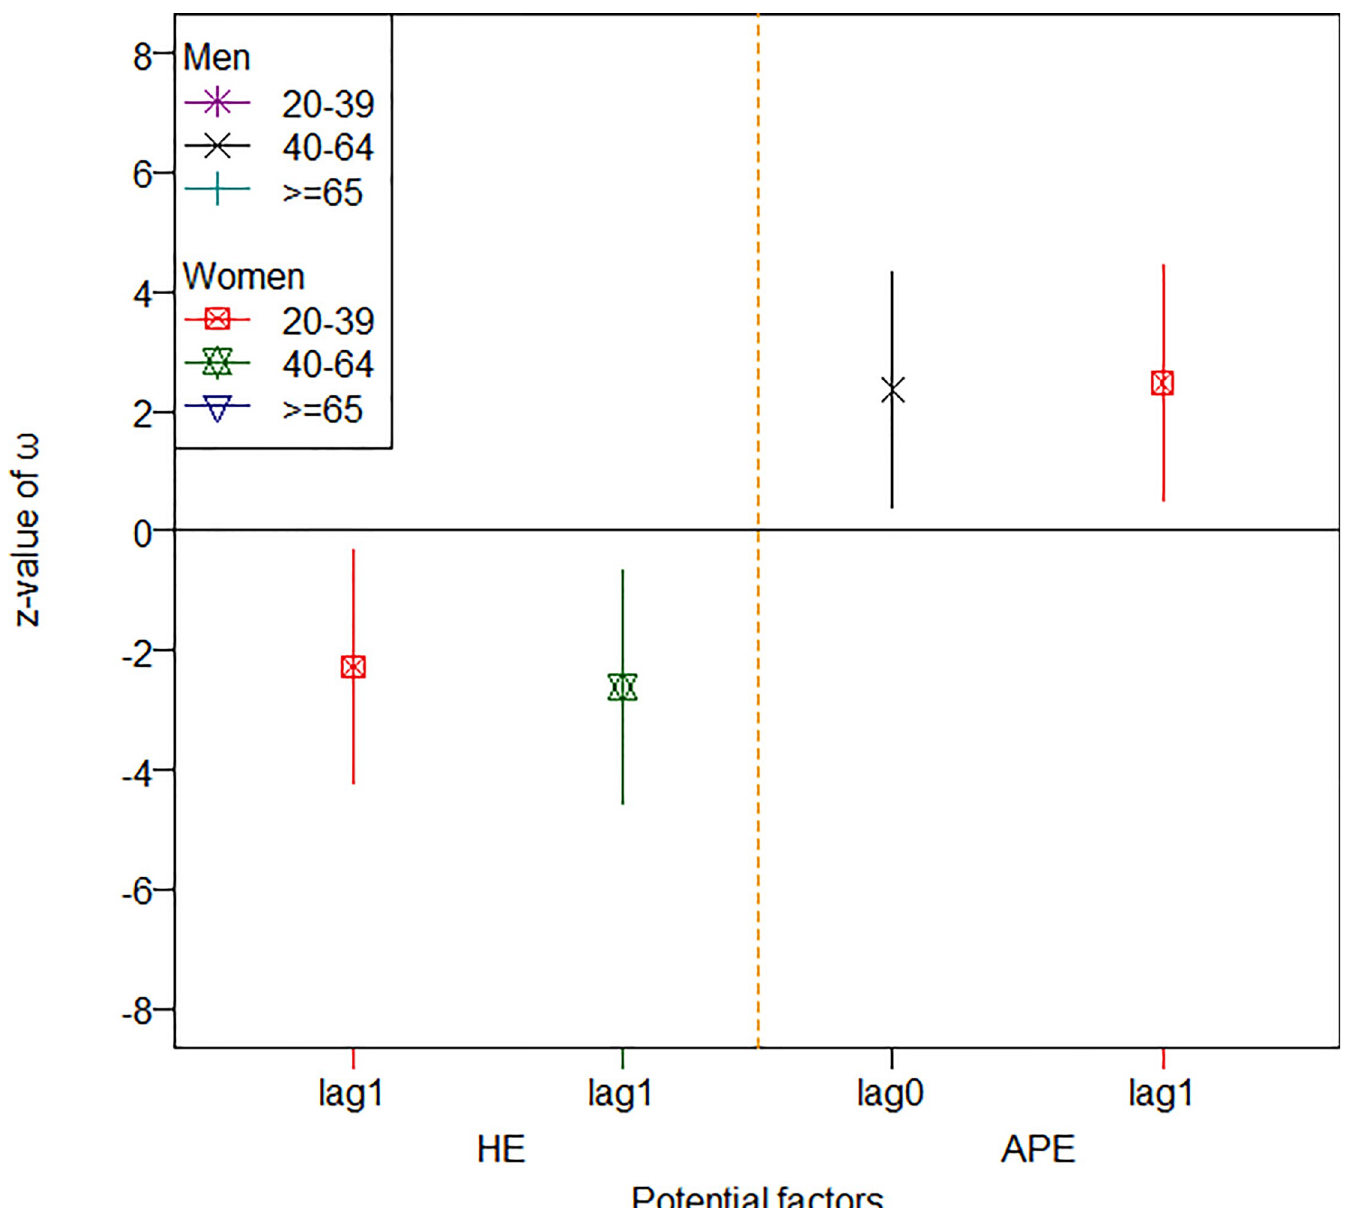
Fig 3. The effects of significant factors on incidence of hypertension. The indicator and solid line present the z-value and 95% coefficient interval of ω , respectively.